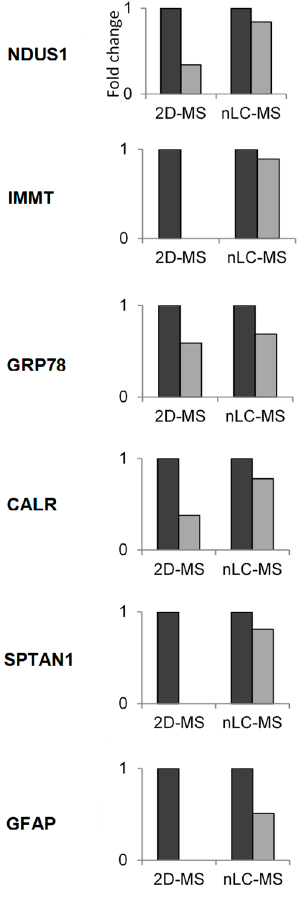
Figure 4. Fold change abundance determined by nanoliquid chromatography-mass spectrometry proteomics procedure nLC-MS of some proteins differentially expressed by two-dimensional electrophoresis followed by mass spectrometry (2D-MS) in response to starvation in the rat. Results are expressed as mean ± S.E.M. The protein-expression level in the starvation (